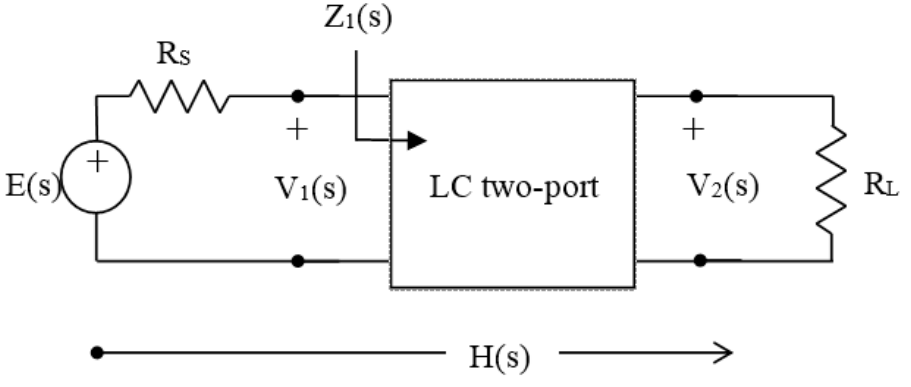
Figure 2. Resistively terminated passive two-port network at source and load [2].